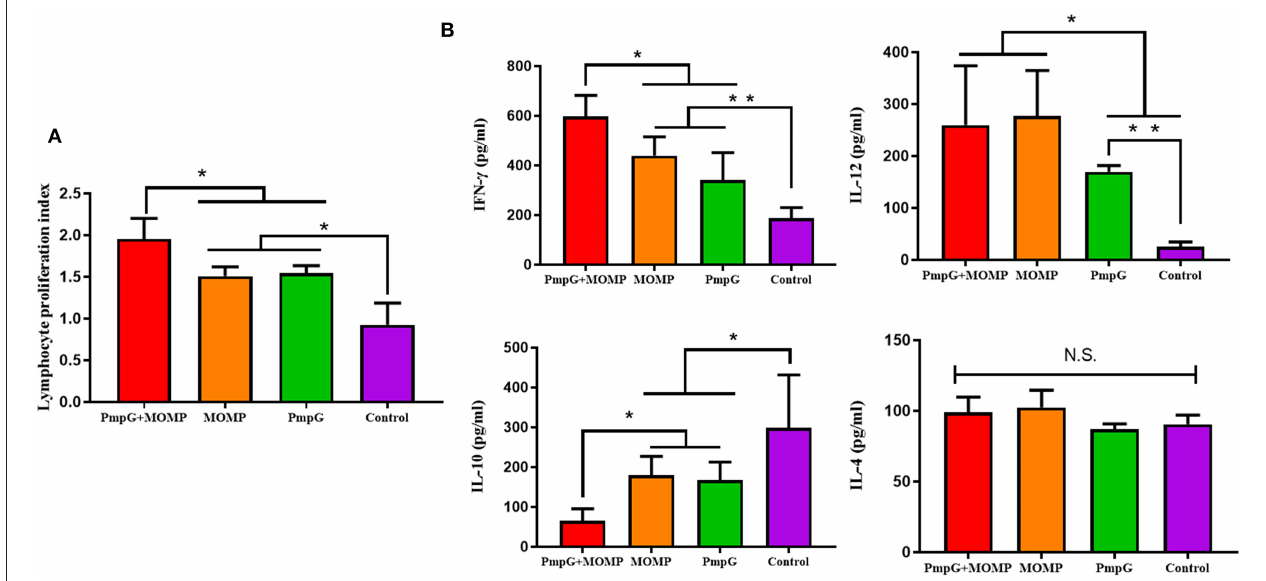
FIGURE 3 | Lymphocyte proliferation and cytokines post inoculation into SPF chickens. (A) Post twice immunizations, the PmpGs + MOMP group induced significant increase of lymphocyte proliferation index compared with the PmpGs group alone and the MOMP group on day 36 ( p < 0.05). (B) IFN- γ expressions were upregulated significantly while IL-10 concentrations were downregulated in the PmpGs + MOMP group in comparison with other groups ( p < 0.05). IL-12 expressions were increased significantly both in the PmpGs + MOMP group and the MOMP group compared with the PmpGs group alone. No significant difference of IL-4 secretion was observed among all the tested groups. The differences were analyzed by ANOVA (* p < 0.05, ** p < 0.01, n.s., no statistical significance).